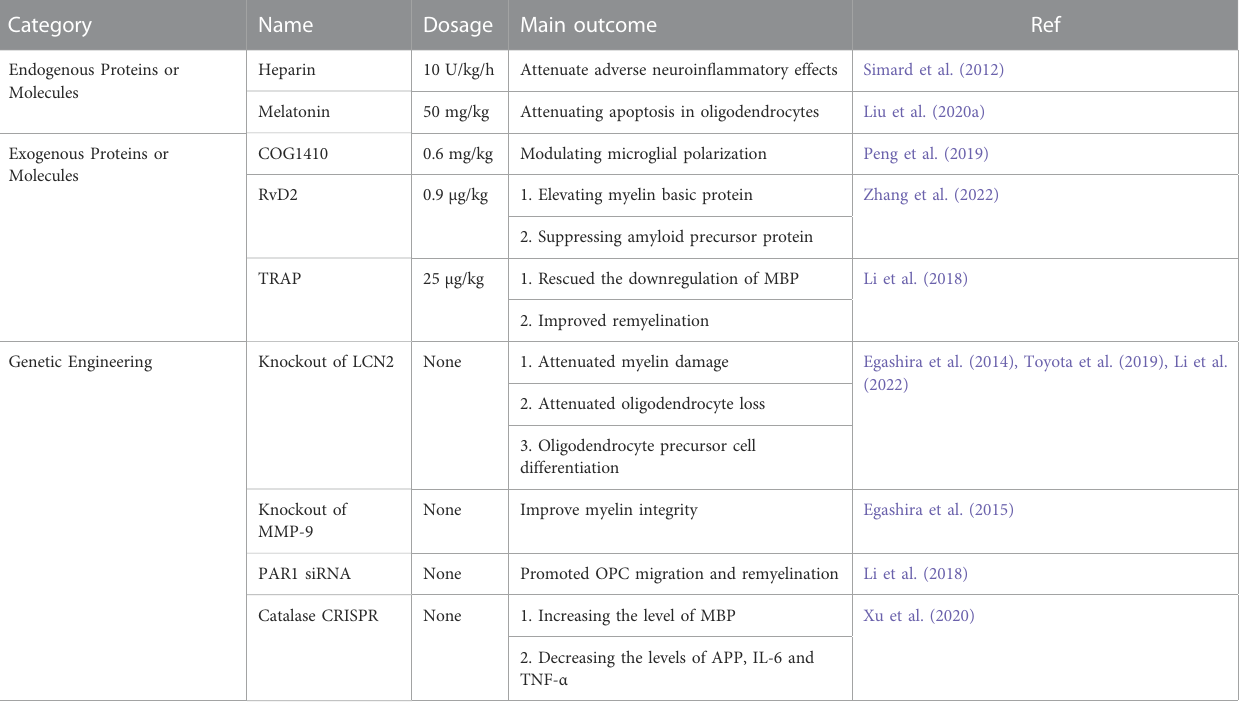
TABLE 1 Summary of therapeutic studies on myelin sheath injury caused by experimental SAH.